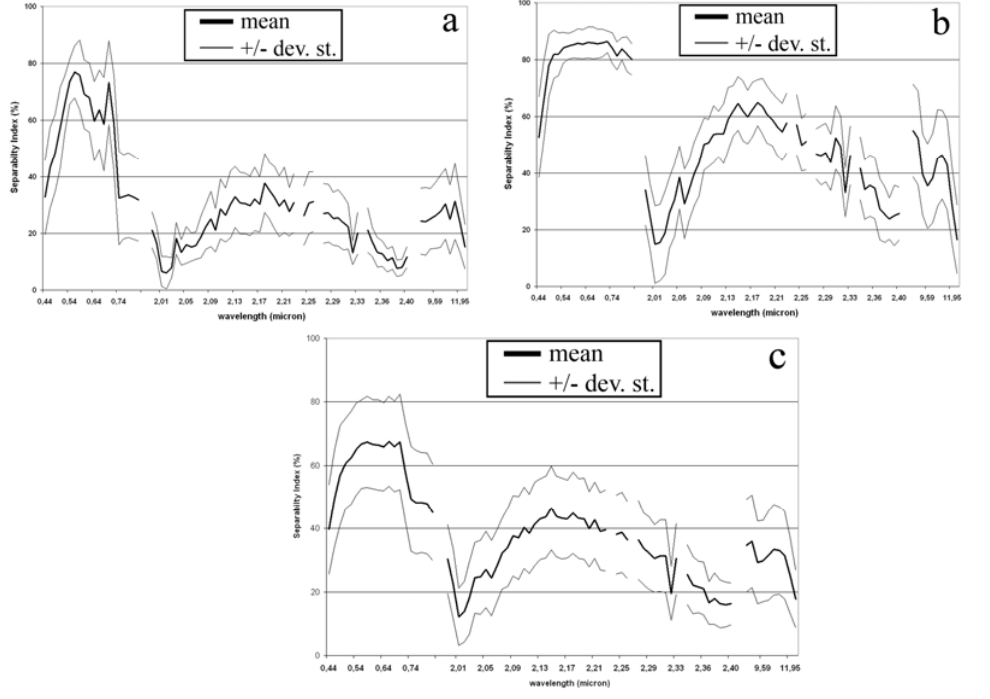
Figure 3. The graphs show the SI trend for the different MIVIS wavelength bands (VNIR, SWIR and TIR spectral regions) for all the test sites showing more than 75 % (from the unmixing results) of (a) green crop and (b) bare soil endmembers. Graph 4c shows the SI behaviour of a mixture of bare soil and green crop